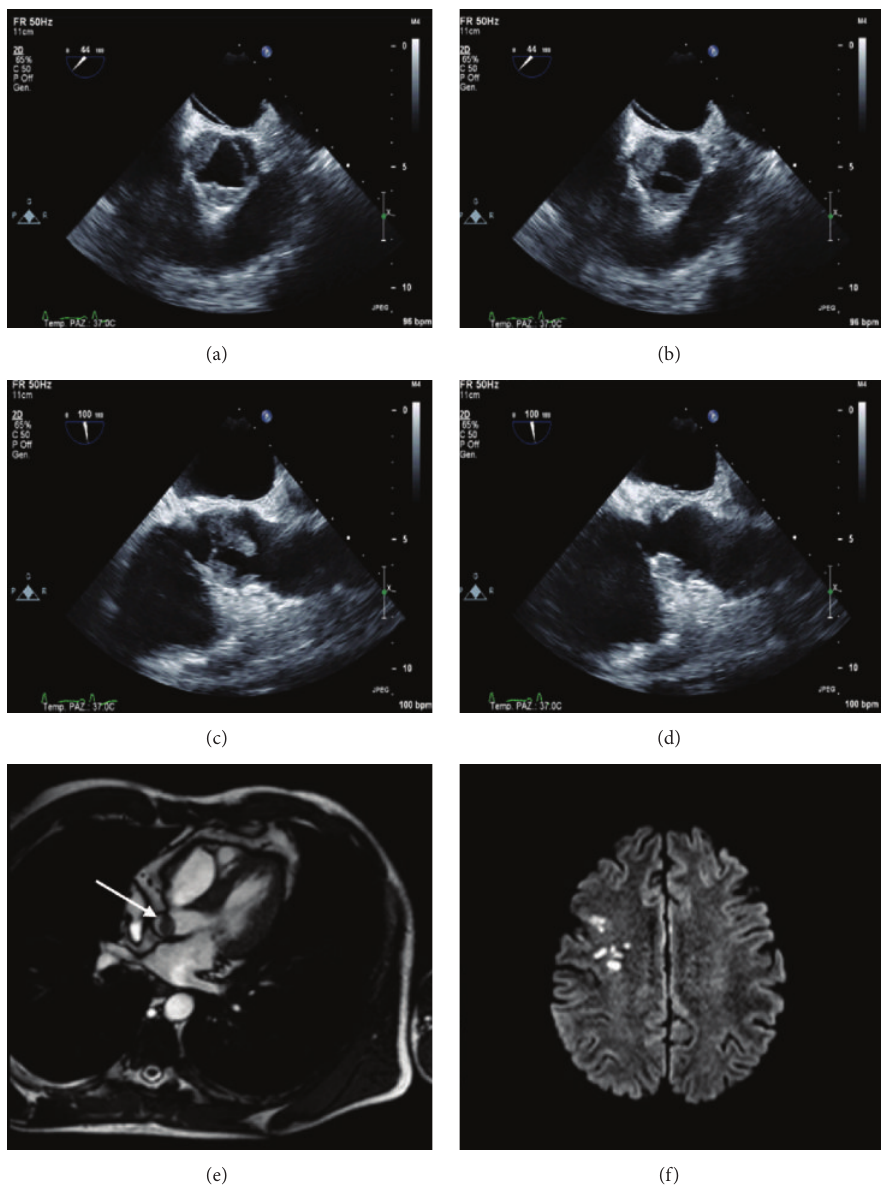
Figure 1: Thrombotic obliteration of the right and no-coronary Valsalva sinuses in systole (a) and diastole (b) in the upper transesophageal short axis view. Floating thrombi attached to the aortic side of the right and no-coronary Valsalva sinuses, extended to the corresponding cusps in diastole (c) and systole (d), in the upper transesophageal long axis view. (e) Cardiac MRI image showing thrombotic mass attached to the aortic valve (arrow). (f) Multiple cortical-subcortical ischemic lesions in the right frontal lobe, at the cerebral